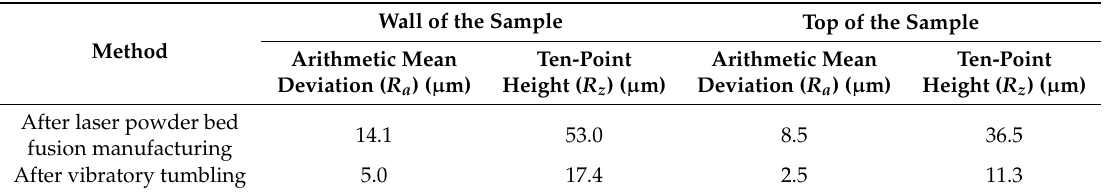
Table 6. The roughness parameters ( R a , R z ) of the 12kH18N9T (AISI 321) steel surfaces before and after vibratory tumbling (before Gaussian